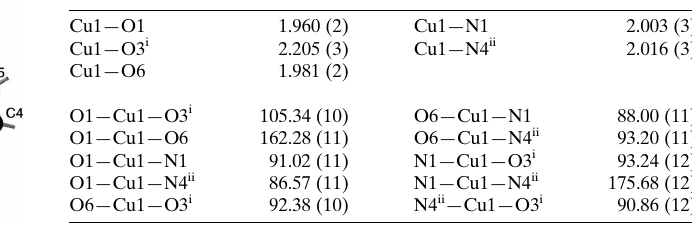
Table 1 Selected geometric parameters (A˚ , (cid:4) ).